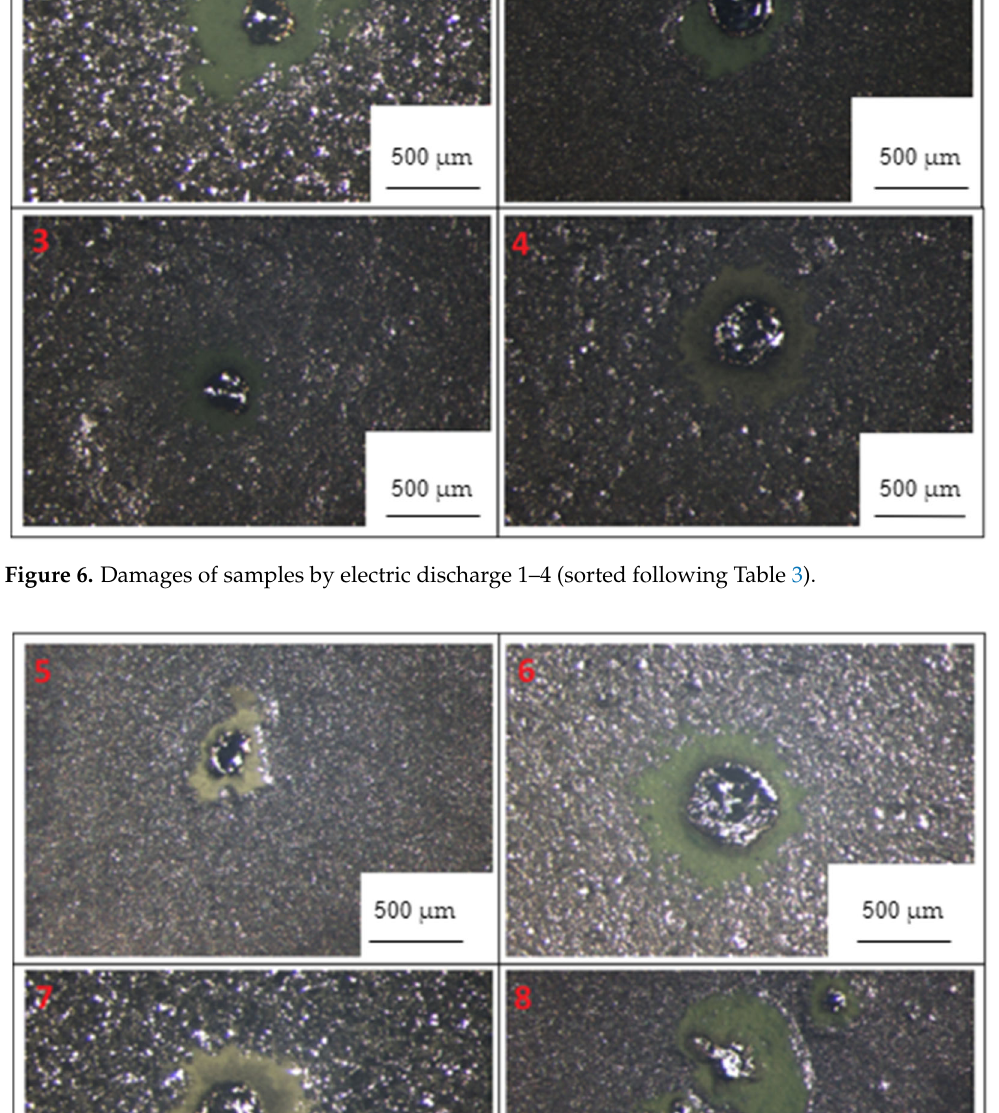
11 of 21 Figure 5. Wide spread homogeneity changes after electric discharge.